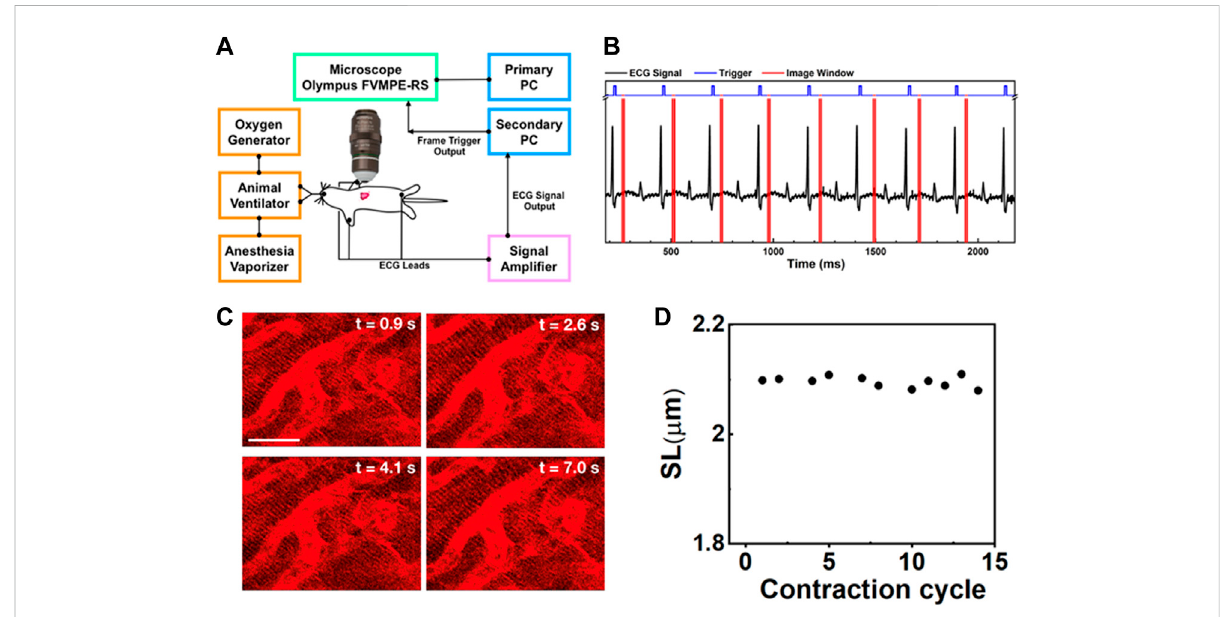
FIGURE 1 (A) Schematic intravital cardiac imaging system. The R waves of ECG signals from the animal are used to trigger the two-photon microscope allowing imaging of the heart at a speci fi c phase during each contraction cycle. (B) The timing diagram used for ECG synchronization of image acquisition — black: ECG signal from the mouse, blue: trigger prompting image acquisition, red: acquisition time window. By tuning the delay time between the R-wave and image acquisition, different phases during the contraction cycle can be imaged. (C) Two-photon images of cardiomyocytes in the beating heart synchronized with the ECG signal at the same phase of four consecutive contraction cycles (label as time points).Thevariation ineachimageisvery smallindicating thatthesystemiscapableofrecordingclearandstable images onabeatingheartwithout image reconstruction. Scale bar: 20 µm. (D) The SL was measured from the images of cardiomyocytes taken at a speci fi c phase in different contraction